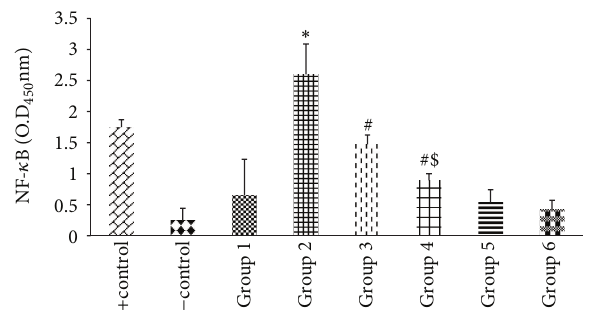
Figure 7: Effect of probiotics on alcohol-induced activation of NF- 𝜅 B in liver. Values are expressed as mean ± S.D. of five different observations. ∗ 𝑃 < 0.001 versus group 1, group 5, and group 6; # 𝑃 < 0.01 versus alcohol (Alc) (group 2); 𝑃 < 0.05 versus group 3. Positive control (+control) refers to the TNF- 𝛼 treated HeLa whole cell extract; negative control ( − control) refers to the biotinylated double stranded nonspecific competitor oligonucleotide probe which does not contain the NF- 𝜅 B consensus sequence. Note: values are not corrected for the protein content. Values are not the same according totheproteincontentasthevalueforproteincontentvaryingby14 ± 5.00 mg/mL of tissue for all the samples.